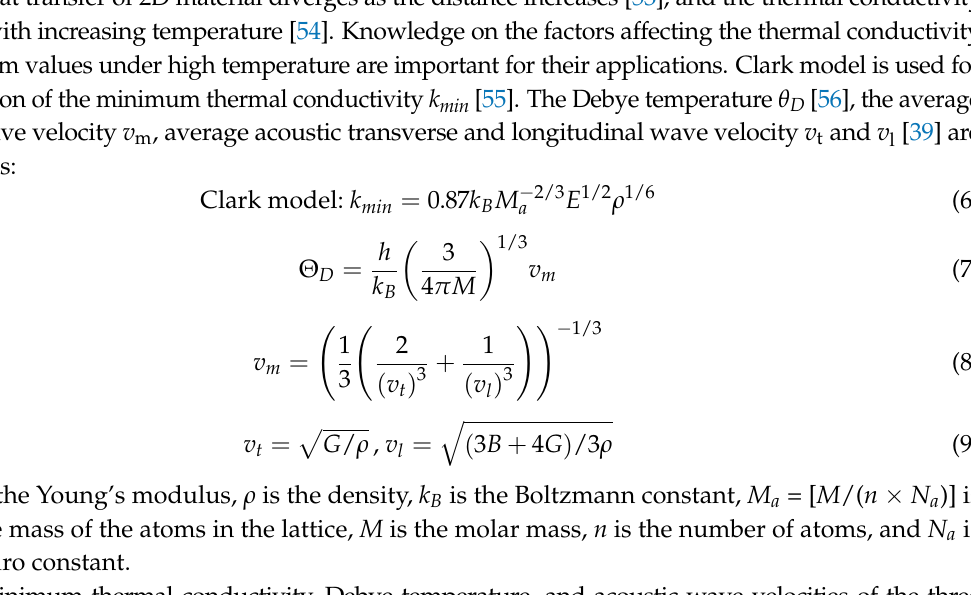
Table 3. The minimum thermal conductivity k min [W/(m·K)], Debye temperature θ D (K), average acoustic transverse wave velocity v t , average acoustic longitudinal wave velocity v l , average acoustic wave velocity v m (km s − 1 ).